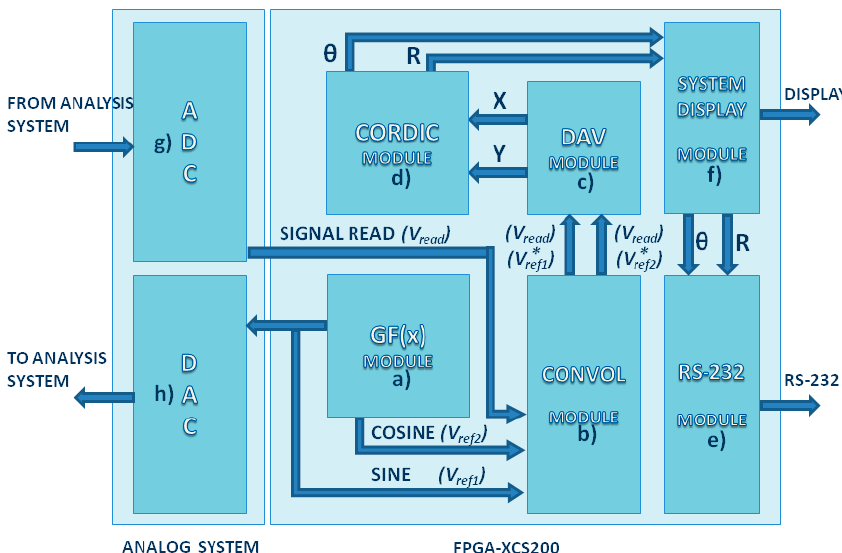
Figure 3. Complete block diagram: ( a ) Generation Function Module; ( b ) Convolution Module;